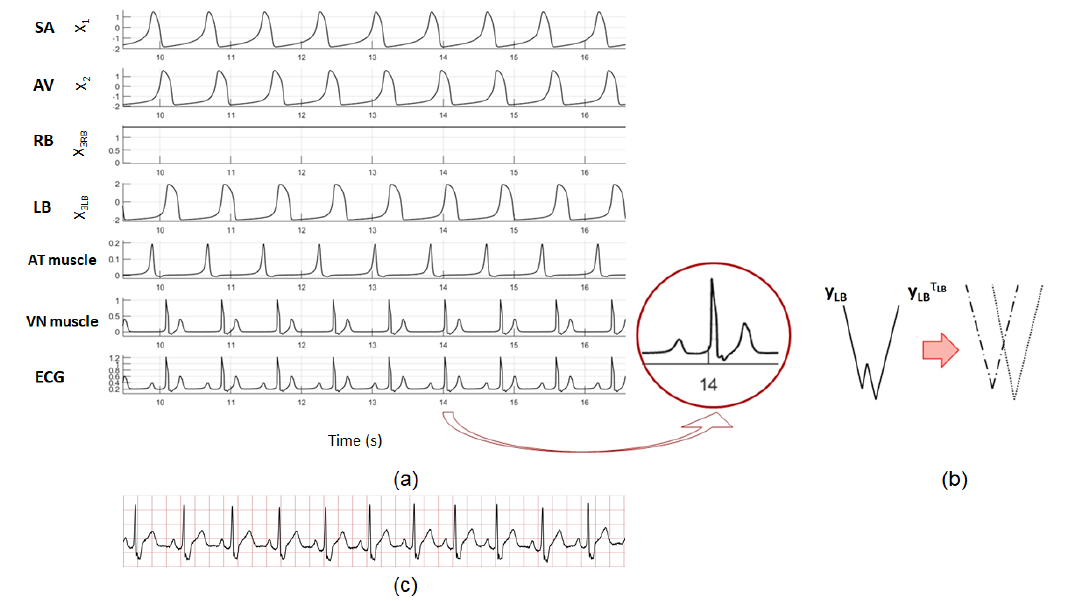
Figure 8. Simulation results for Right Bundle Branch block (RBBB). ( a ) action potentials, muscles response and ECG signal in the RBBB case; ( b ) slurred S-wave due to the rapid depolarization of the left ventricle followed by the slower depolarization of the right ventricle; ( c ) real ECG signal affected by RBBB